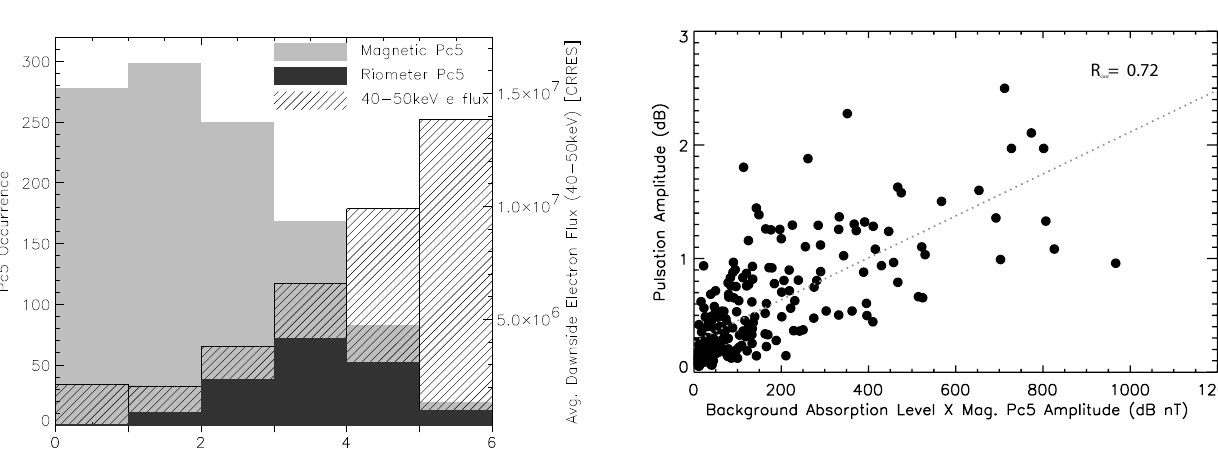
Fig. 8. Correlation between the amplitude of modulated precipita- tion and background absorption level multiplied by the amplitude of the magnetic pulsation (X-component).